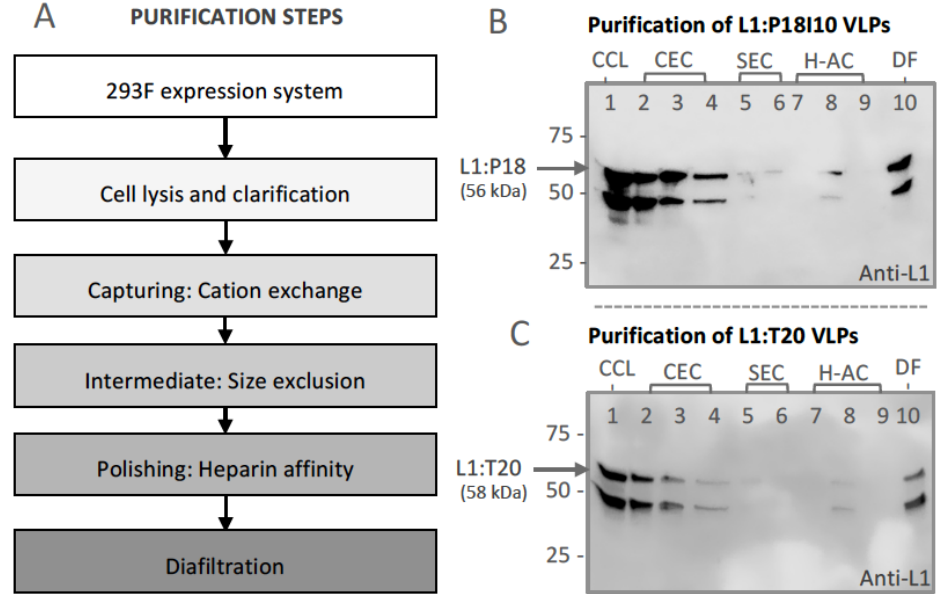
Figure 2. Purification and characterization of L1:P18I10 and L1:T20 VLPs. ( A ) Schematic process flowchart of L1:P18I10 and L1:T20 VLP purification by chromatography. ( B , C ) Western blot analysis of L1:P18I10 and L1:T20 VLP samples from each purification step. The signal of L1 in each purification step was characterized by Western blot analysis probed with anti-HPV16 L1 mAb. The arrow indicates the molecular weight ~56 kDa of L1:P18I10 and ~58 kDa of L1:T20 proteins. Lane 1: clarified cell lysate (CCL); Lane 2: flow-through (FT) from cation exchange chromatography (CEC)